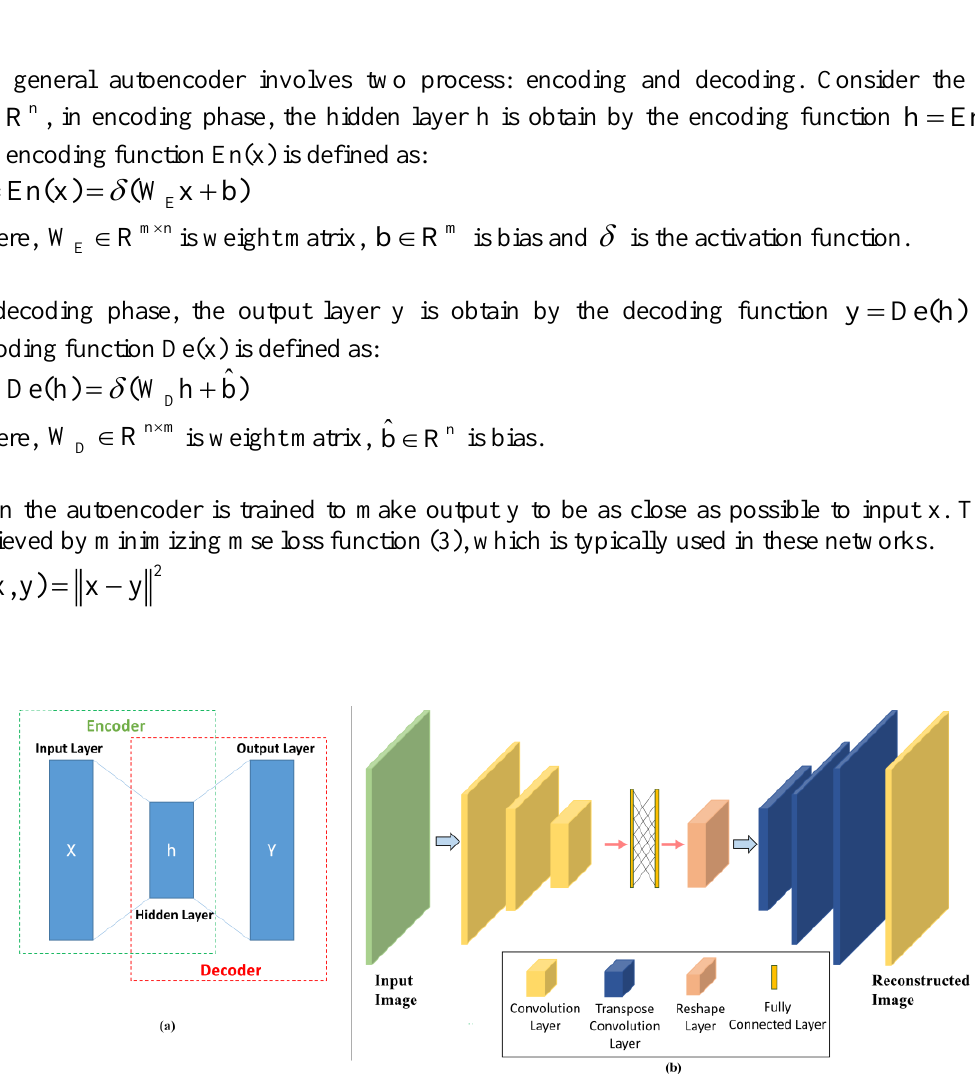
Figure 2. (a) General Autoencoder architecture. (b) General Convolutional Autoencoder